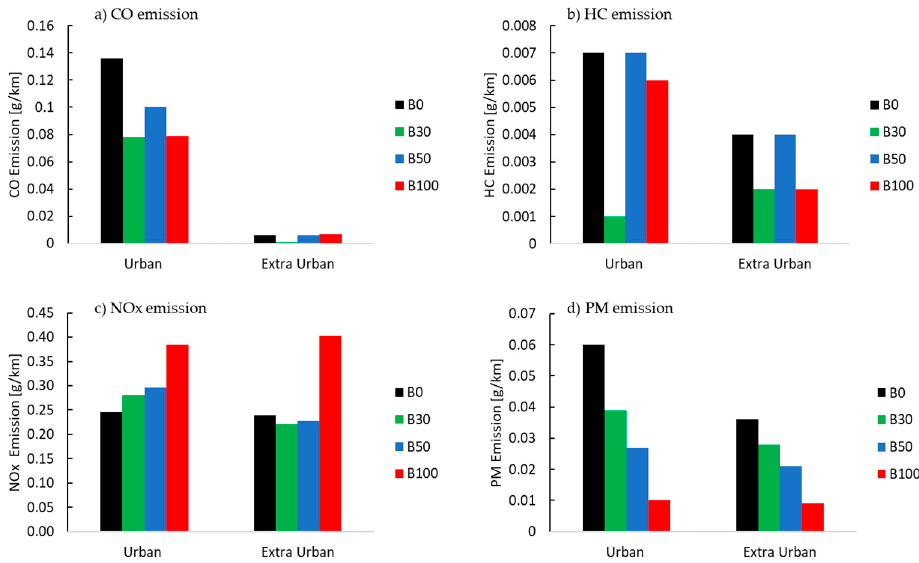
Figure 3. Regulated exhaust gas emissions for B0, B30, B50 and B100.